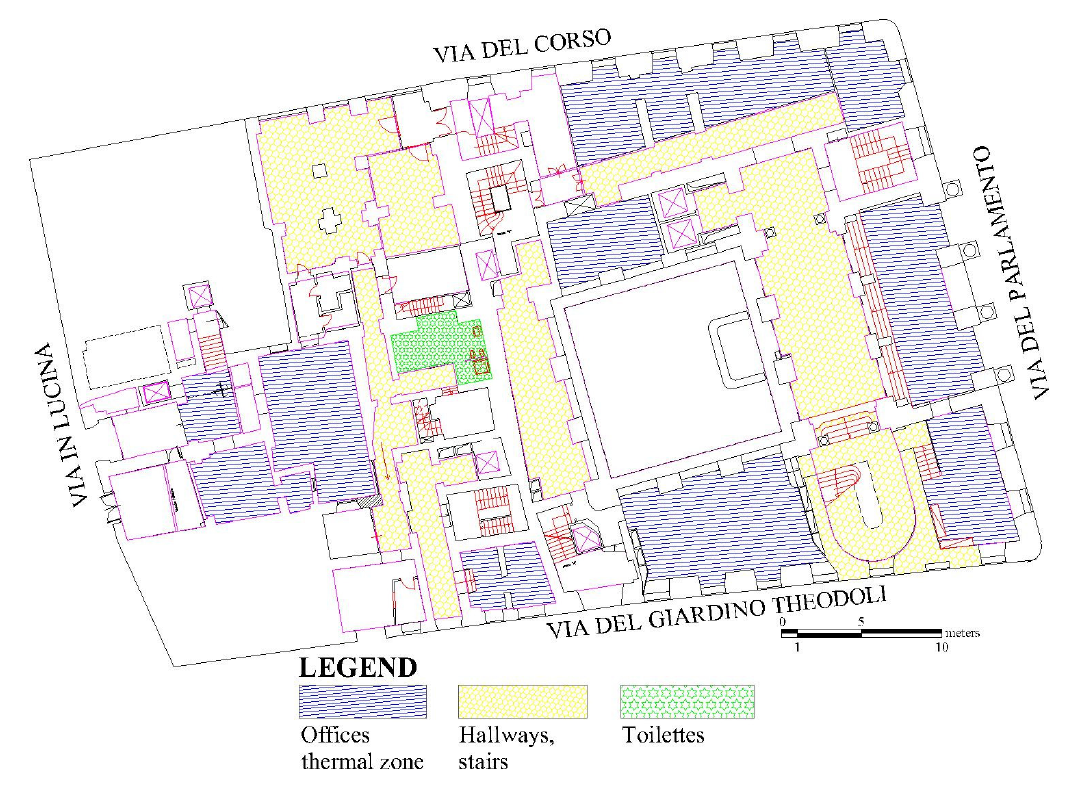
Energies 2022 , 15 , x FOR PEER REVIEW